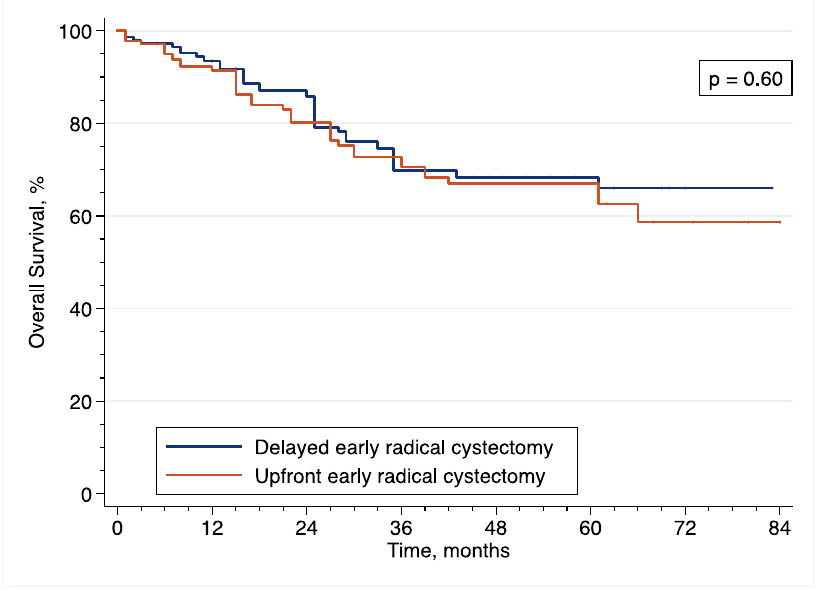
Figure 8. Inverse probability of treatment weighting (IPTW)-adjusted Kaplan–Meier curves that compare the OS of included patients treated with upfront or delayed eRC for HR-NMIBC.